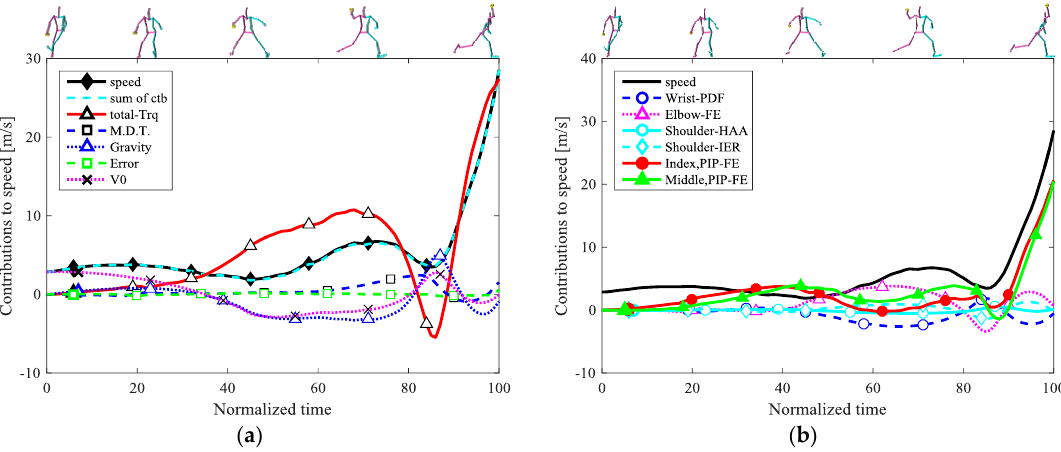
Figure 2. Contributions to the ball speed with respect to the 22-segment model: ( a ) contributions of the individual terms; ( b ) contributions of individual joint torque terms. The legends in Figure 2a,b are as follows, speed: measured ball speed; total-Trq: total contribution of joint torque terms; V0: the contribution of initial velocity term; sum of ctb: total sum of individual terms; PDF: palmar/dorsal flexion; FE: flexion/extension; HAA: horizontal abduction/adduction; IER: internal/external